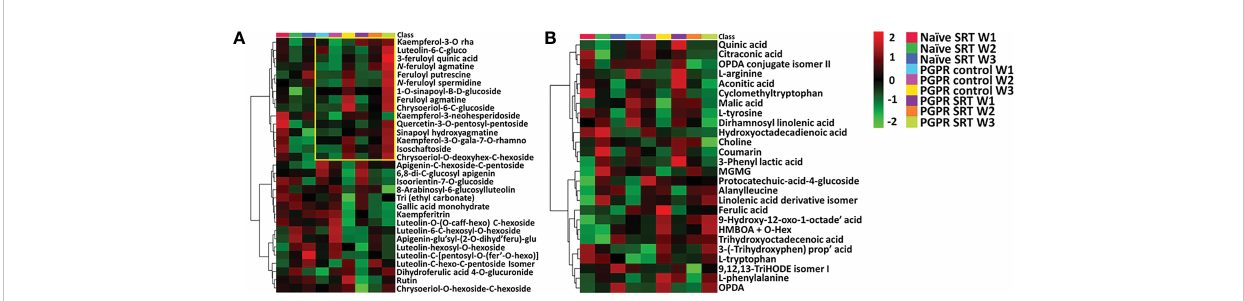
FIGURE 2 Interactive heatmap analysis of putatively annotated metabolite pro fi les from primed and non-primed infected and control Gariep cultivar samples. (A) A heatmap showing the differential qualitative and quantitative distribution of phenolic compounds and fl avonoids in the PGPR-primed control and infected (SRT) plants vs. non-primed infected (naïve SRT) plants. (B) A heatmap that describes the relative quanti fi cation of annotated metabolites (amino acids, organic acids, fatty acids and benzenoid derivatives) detected in primed and non-primed Gariep samples over a three- week timepoint following Pst infection. Upregulated metabolites are shown in red whereas downregulated metabolites are indicated by a green rating on the heatmap, black shading shows no changes in the metabolite concentrations. The data projected above were median-normalised, log transformed and Pareto-scaled in MetaboAnalyst. The heatmap analysis thus showed the time-dependent perturbations in metabolic pro fi les of wheat plants due to plant priming and pathogen infection, compared to non-primed plant